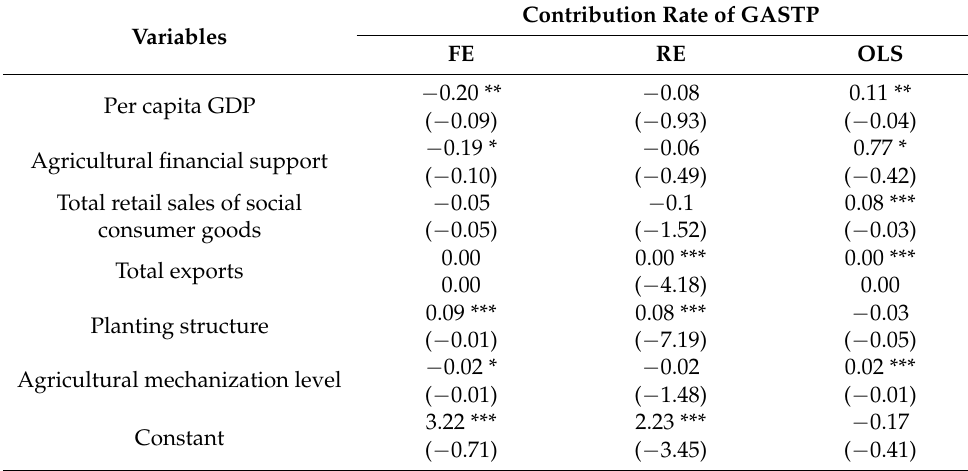
Figure 4. LISA of the contribution of GASTP in 2011, 2013, 2015, 2018, and 2020. Table 4. Estimation results of the panel data